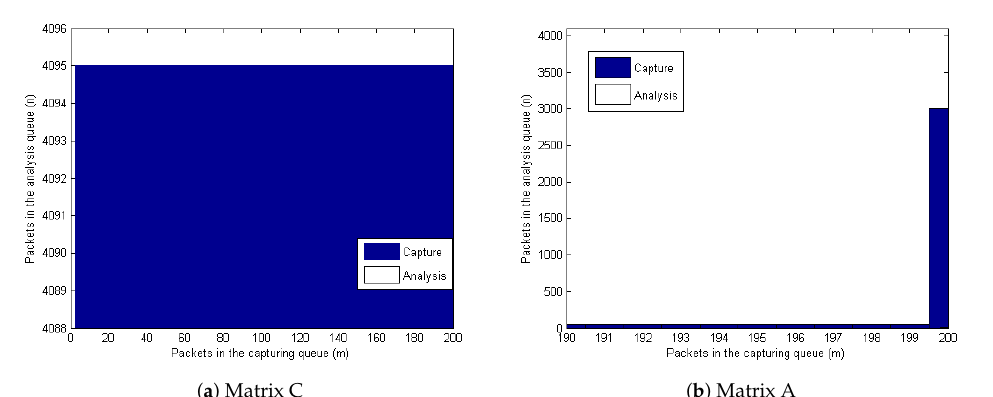
Figure 5. Optimal policy with network traffic rate of 620,000 pps and null analysis load.